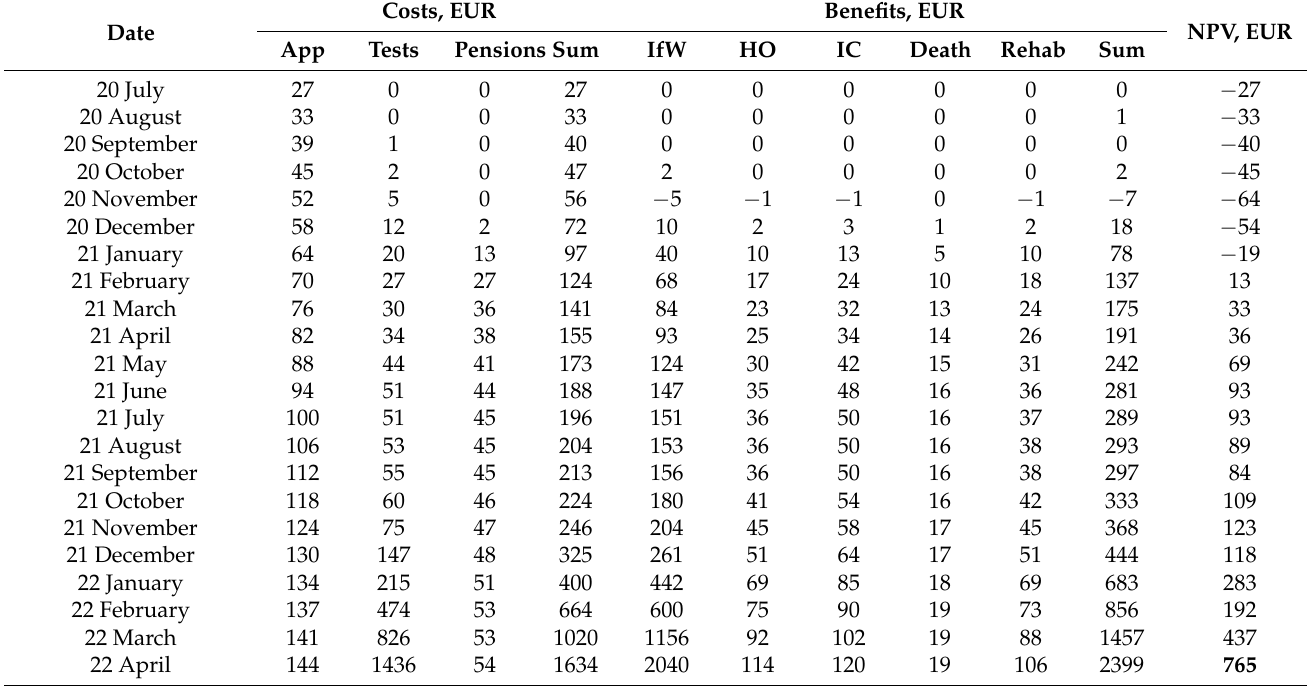
Table 2. Cumulative discounted costs and benefits over